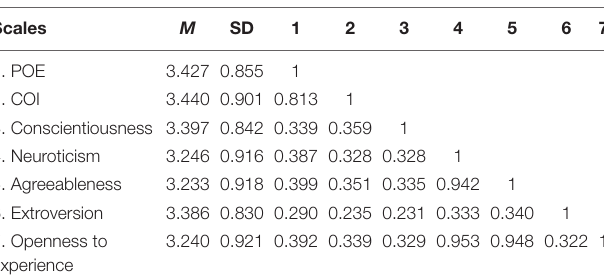
TABLE 2 | Descriptive statistics and latent correlations among the measured variables.